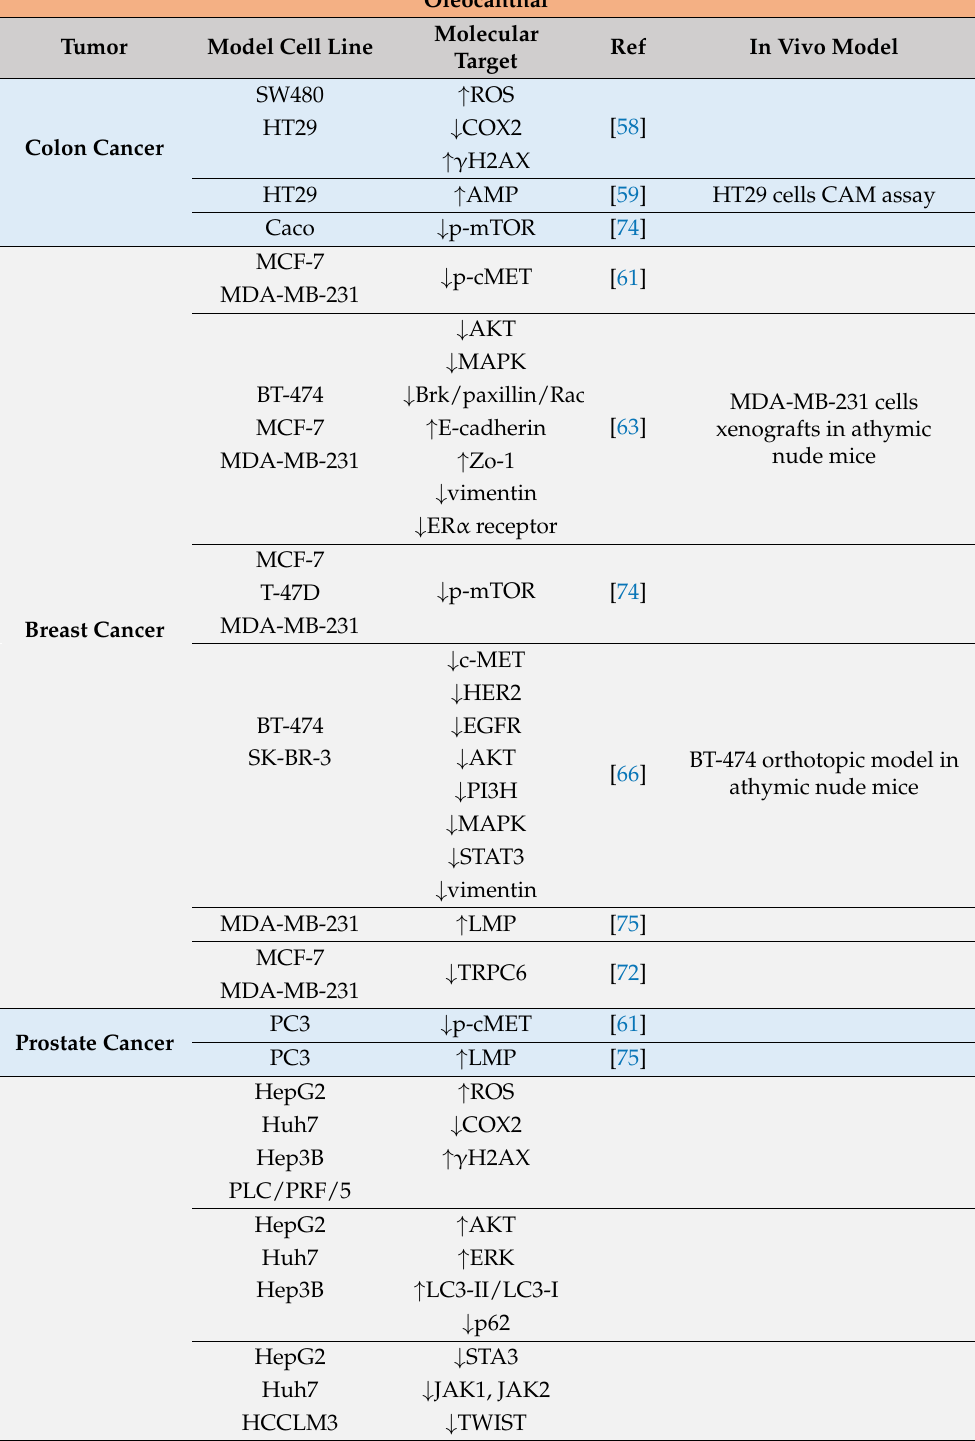
Table 1. Anti-cancer effects of Oleocanthal and Oleacein: in vitro and in vivo